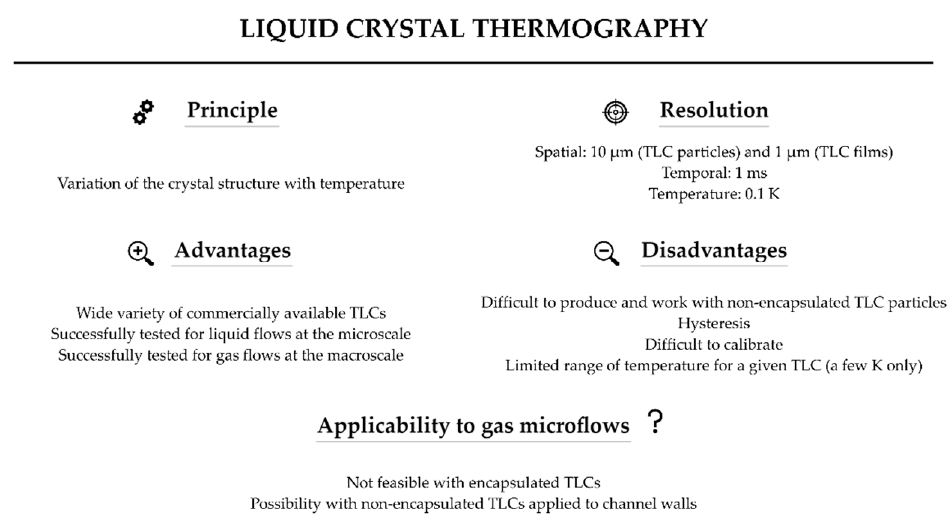
Figure 13. Summary of the main features of thermochromic liquid crystals. Values of spatial resolutions are from [73], value of temperature resolution is from [69,78] and value of temperature resolution is from [73,75].